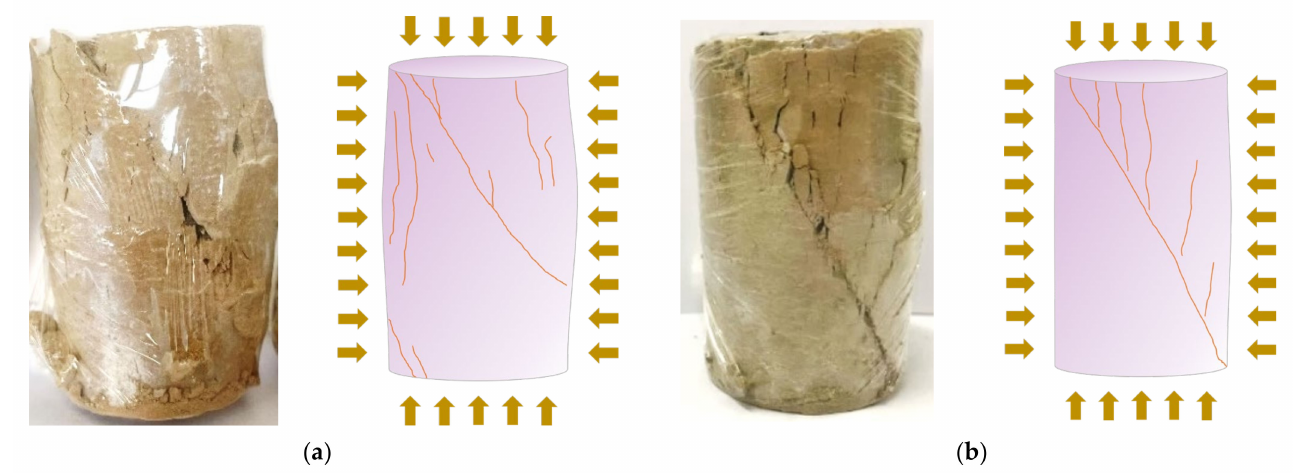
Figure 8. The failure of two specimens under confining pressure of 0.9 MPa: ( a ) LC-0 specimen group and ( b ) LC-12 specimen